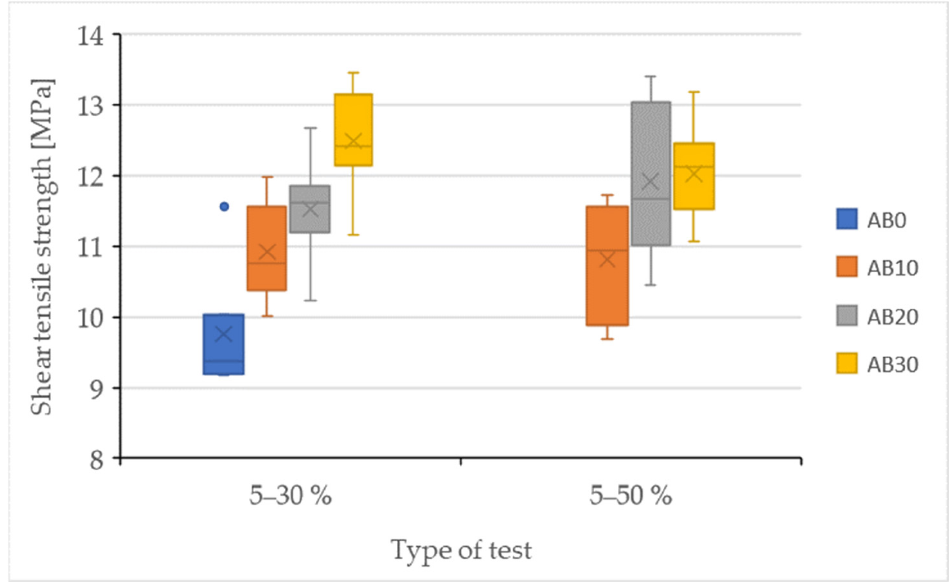
Figure 6. Results of the quasi-static test of adhesive bonds—strength.